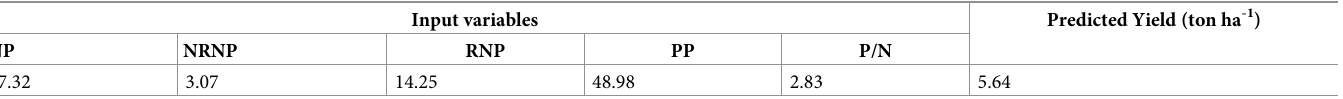
Table 1. Optimizing the number of nodes per plant (NP), the number of non-reproductive nodes per plant (NRNP), the number of reproductive nodes per plant (RNP), and the number of pods per plant (PP), the ratio of number of pods to number of nodes per plant (P/N) according to the E-B-GA for maximizing soybean seed